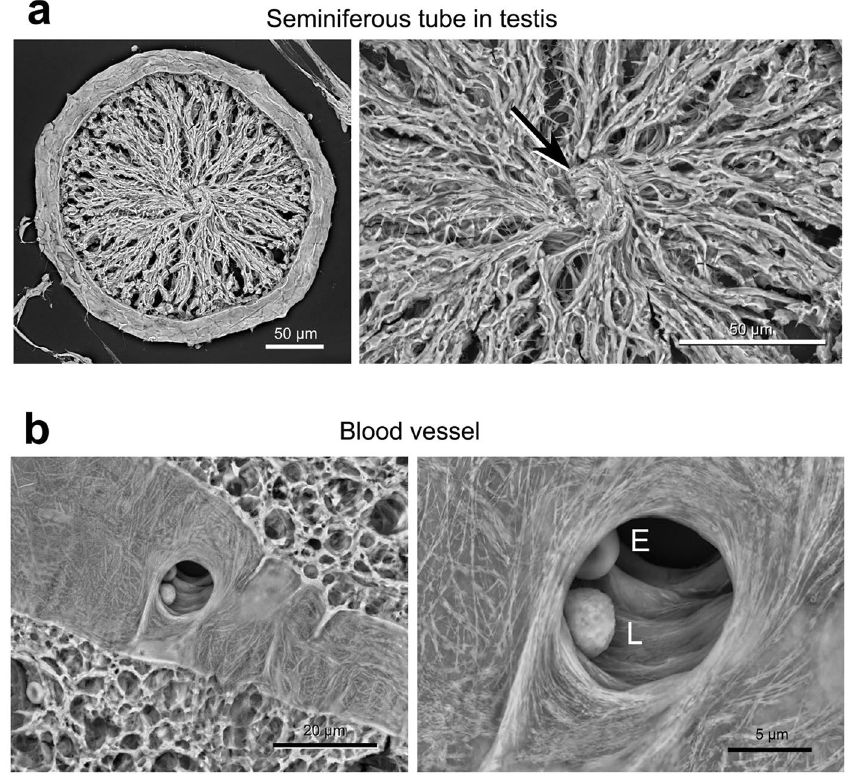
Figure 6. Representative micrograph of rat testis and blood vessel. Electron micrographs were taken from 30 µ m sections. ( a ) Seminiferous tubule in the testis. Differentiated sperm cells are assembled in the centre (arrow). ( b ) A blood vessel in the spinal cord. Note the vascular endothelium and its bifurcation with erythrocyte (E) and leukocyte